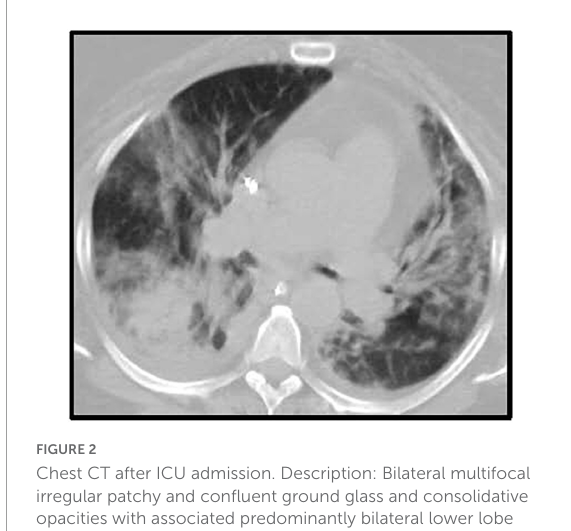
FIGURE2 Chest CT after ICU admission. Description: Bilateral multifocal irregular patchy and confluent ground glass and consolidative opacities with associated predominantly bilateral lower lobe irregular reticulations. Small (right) and trace (left) pleural effusion. CT, computerized tomography; ICU, intensive care unit.